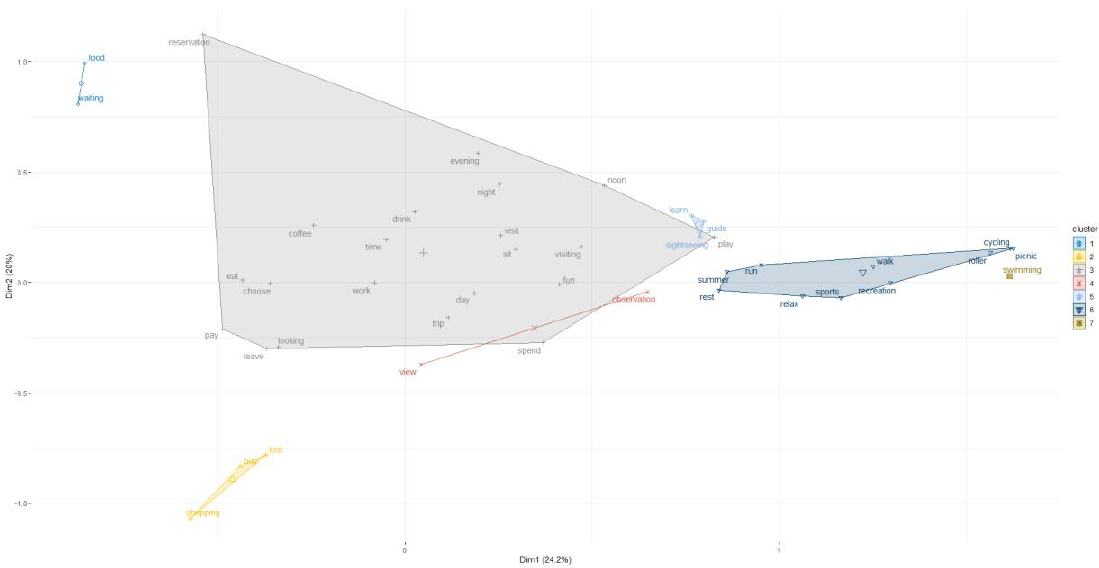
Figure 5. Hierarchical clustering of place practices dimension terms. The x − axis and y − axis indicate percent of variance